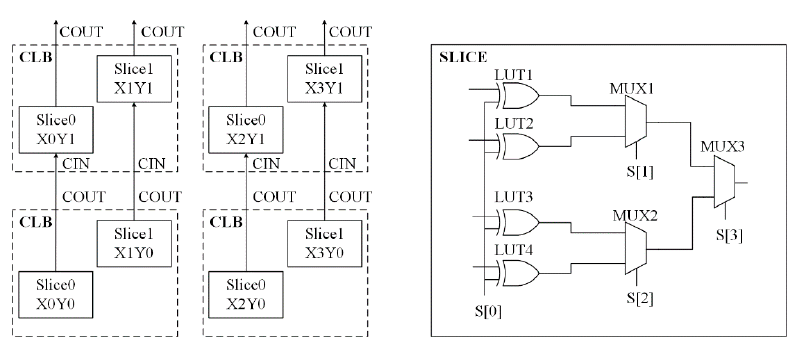
Figure 8. Hardware resource of Xilinx A-7 field programmable gate arrays (FPGA).